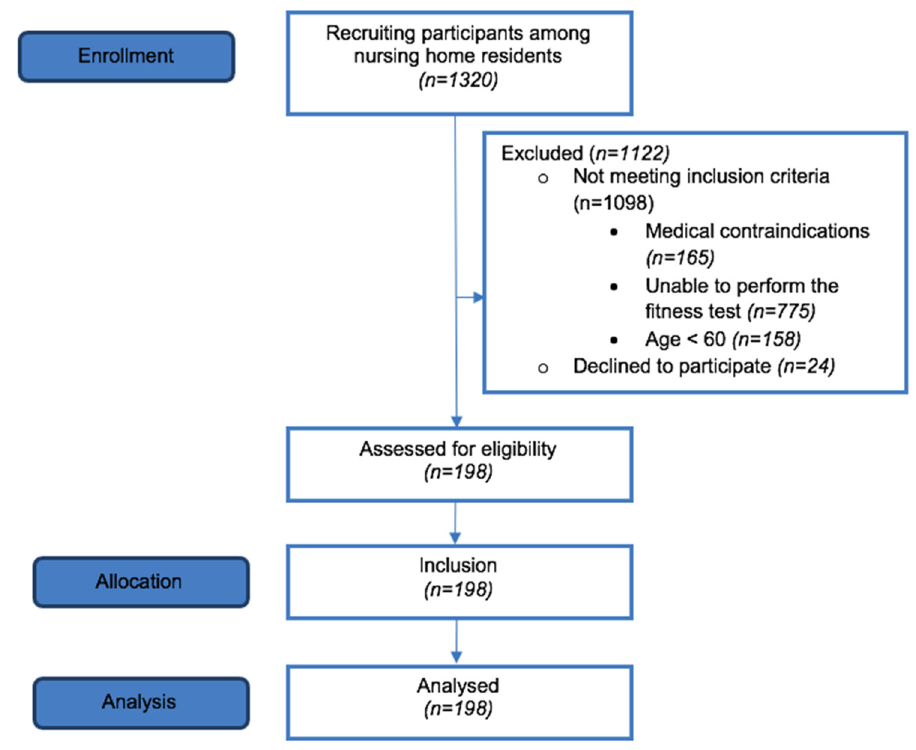
Figure 1. Flow diagram of the study.